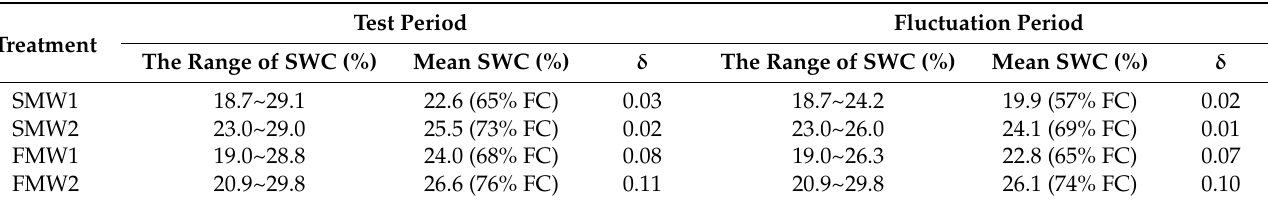
Figure 3. E ff ects of di ff erent treatments on the fresh weight (FW) ( A ) and dry weight (DW) ( B ) of tomato organs on the 21st day after treatment. Values are the mean ± SD (n = 3). Duncan’s multiple-range test was used to test for di ff erences among treatments at the p < 0.05 level. Di ff erent lowercase le tt ers above the columns indicate signi fi cant di ff erences among treatments within the same organ.